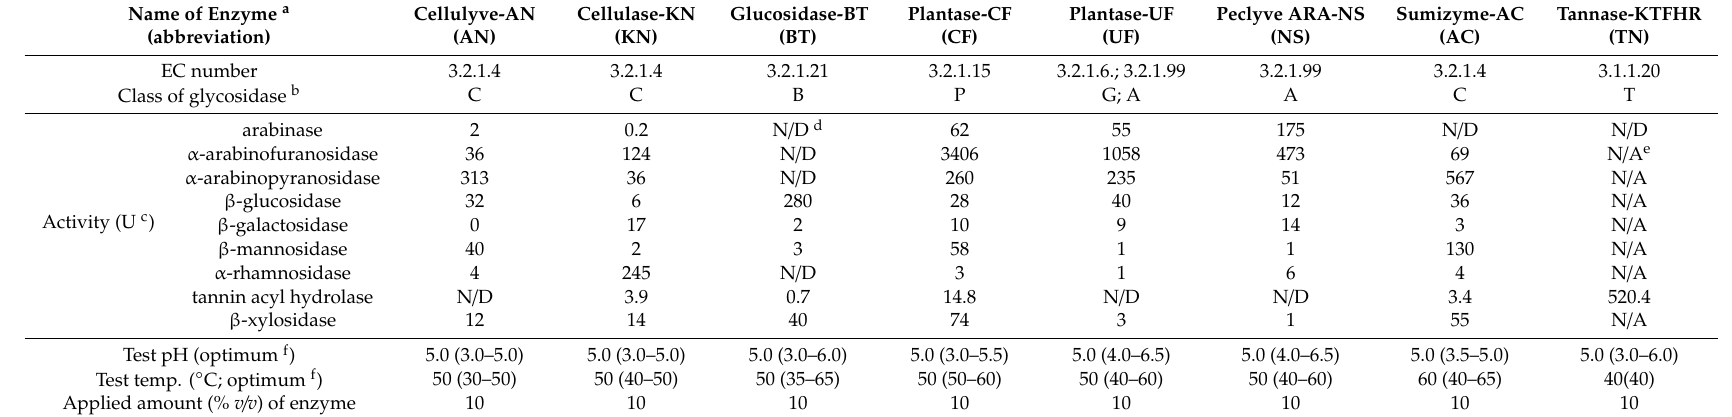
Table 1. Characteristics of enzymes and test conditions of screening for hydrolyzing flavonol glycosides in green tea